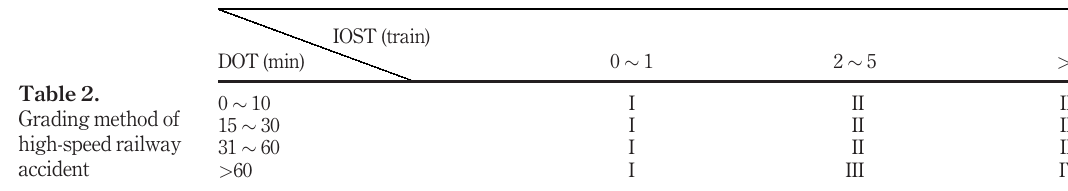
Table 2. Grading method of high-speed